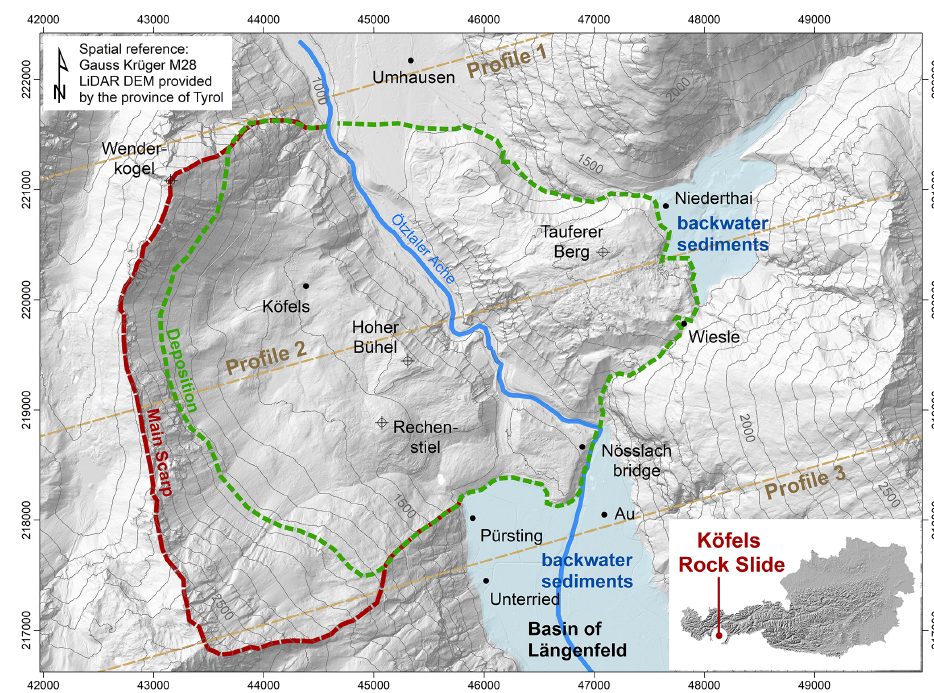
Figure 2. Overview map of the Köfels rockslide